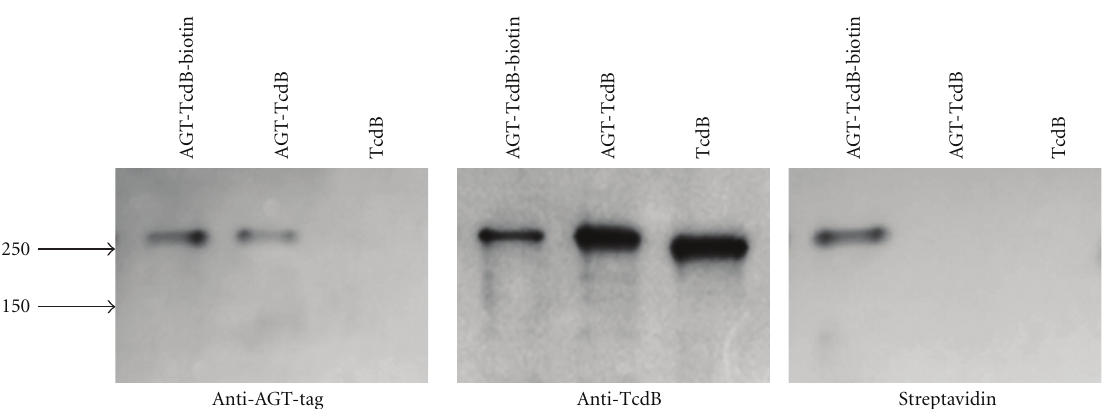
Figure 2: AGT-tag expressed at the N-terminus of TcdB retains enzymatic activity. Recombinant TcdB and AGT-TcdB were expressed and purified. 250 ng aliquots of purified TcdB and AGT-TcdB ( ± autobiotinylation) were analyzed by Western blots using anti-AGT-tag sera (left) and by anti-TcdB sera (middle). The positions of molecular weight markers are indicated with arrows. Each of the protein preparations was subjected to enzymatic reactions with BG-biotin and analyzed for bound biotin by Western blot with streptavidin (right). The data shown are representative of 2 independent experiments.